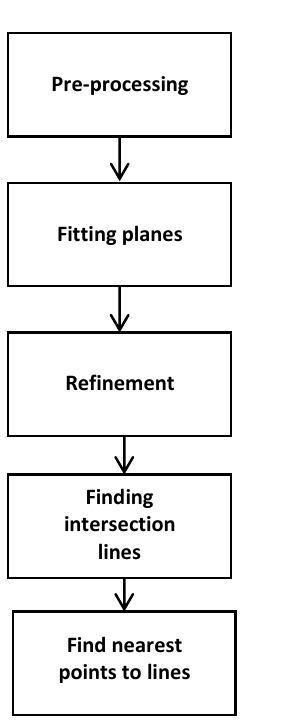
Figure 2. flowchart of the proposed method.